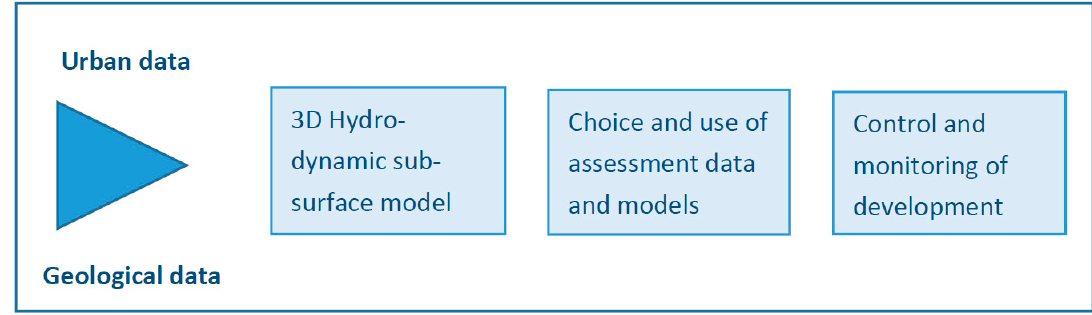
Figure 3. The four steps: Subsurface urban data, Subsurface modelling, Assessment, and Monitoring. Requirements of a City Scale Concept Hydrodynamic Model